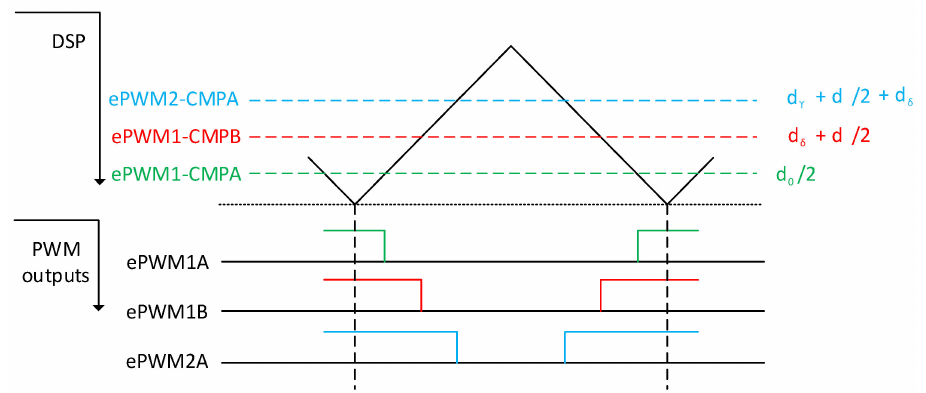
Figure 5. Process of the encoding vector times for the rectifier to the